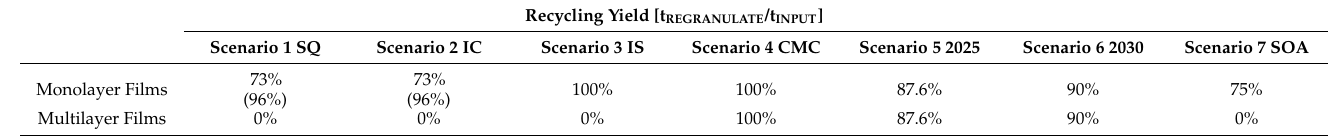
Table 6. Recycling yield of the target fraction depending on the scenarios.